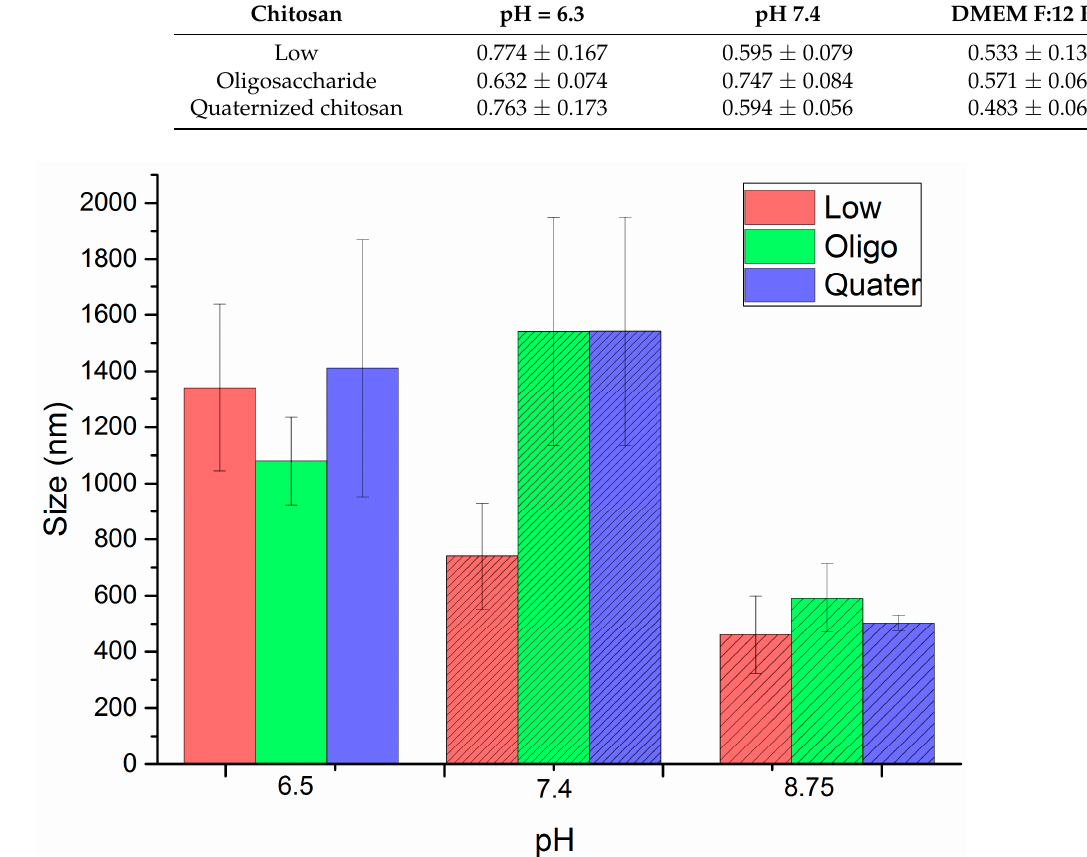
Figure 8. Particle size variation as a function of pH for each of the synthesized